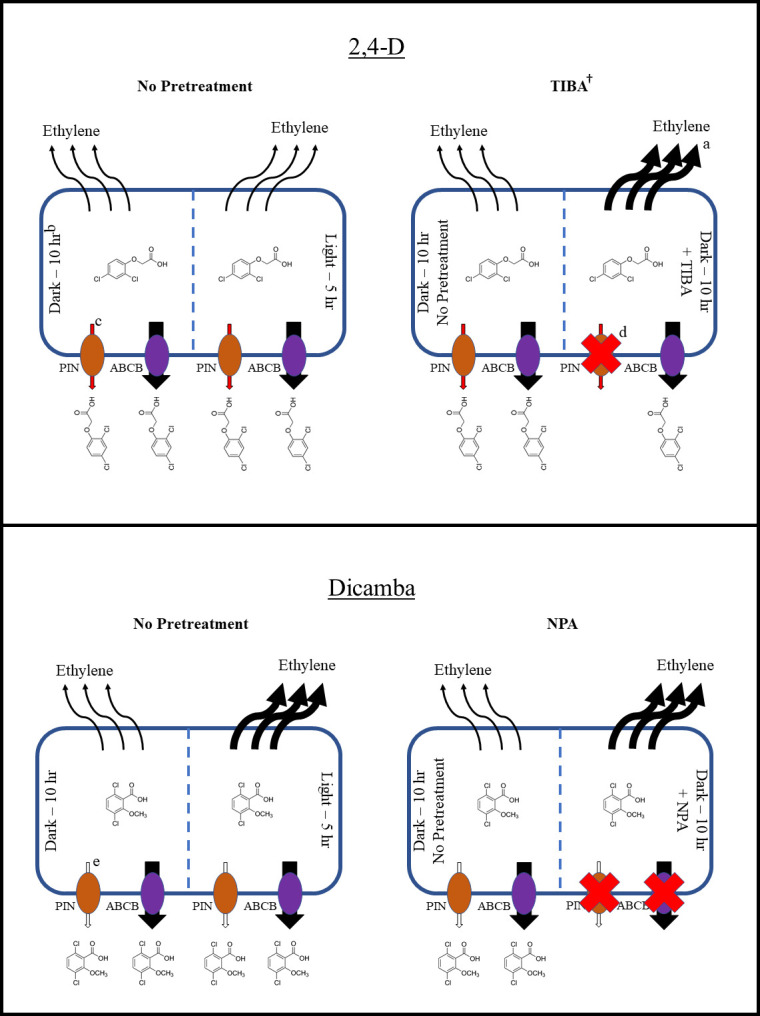
Diagrams illustrating differences in 2,4-D and dicamba-induced ethylene production from plant cells across application times, and across 8 am applications with no pretreatment and TIBA and NPA pretreatment, respectively.aSize of black arrows indicate magnitude of ethylene production. bDark– 10 h indicates the 8 am, simulated dawn application, as applications were made after 10 h of darkness. Light– 5 h indicates the 1 pm, simulated mid-day application, as applications were made after 5 h of light. cRed arrows indicate probable 2,4-D efflux via PIN transport proteins. dRed “X” indicates likely total inhibition of efflux via respective transport protein. eWhite arrows indicate unknown extent, if any, of dicamba efflux via PIN proteins.